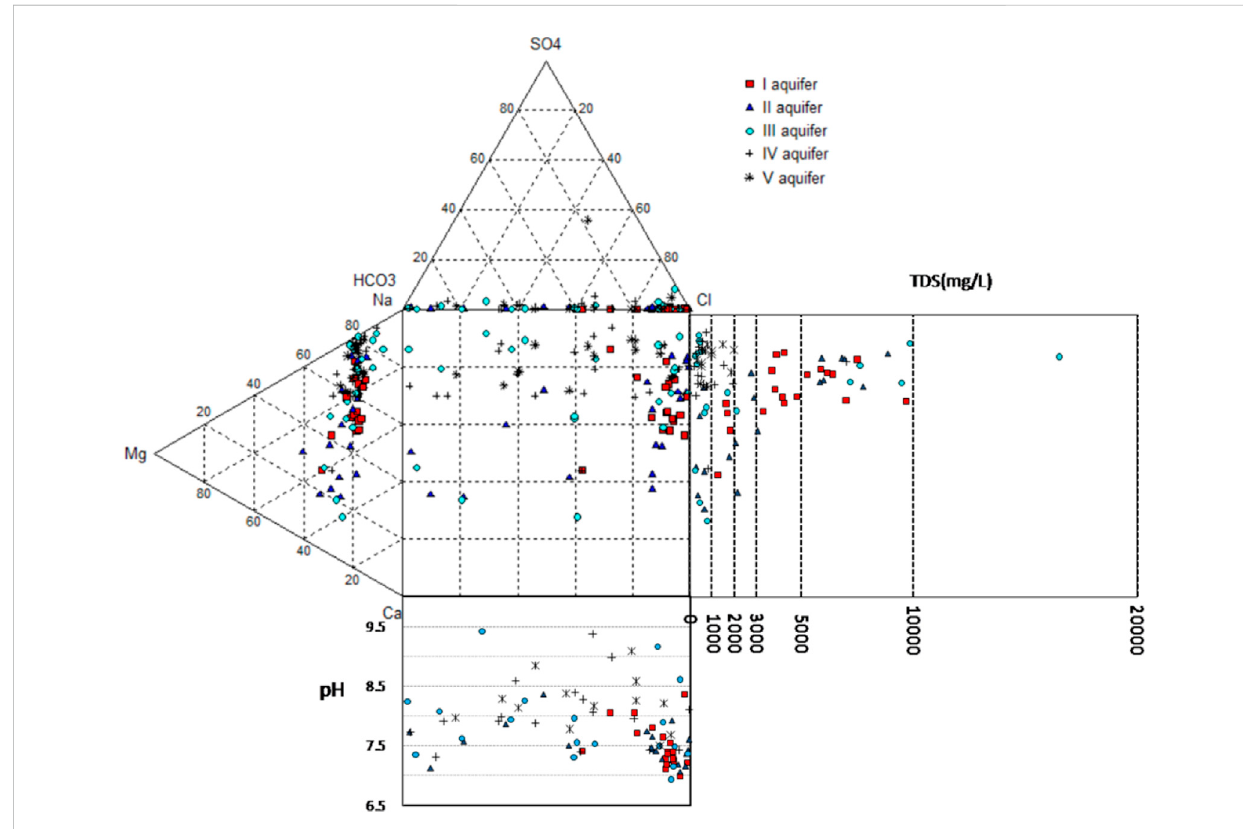
FIGURE 5 Durov diagram for con fi ned groundwater samples.